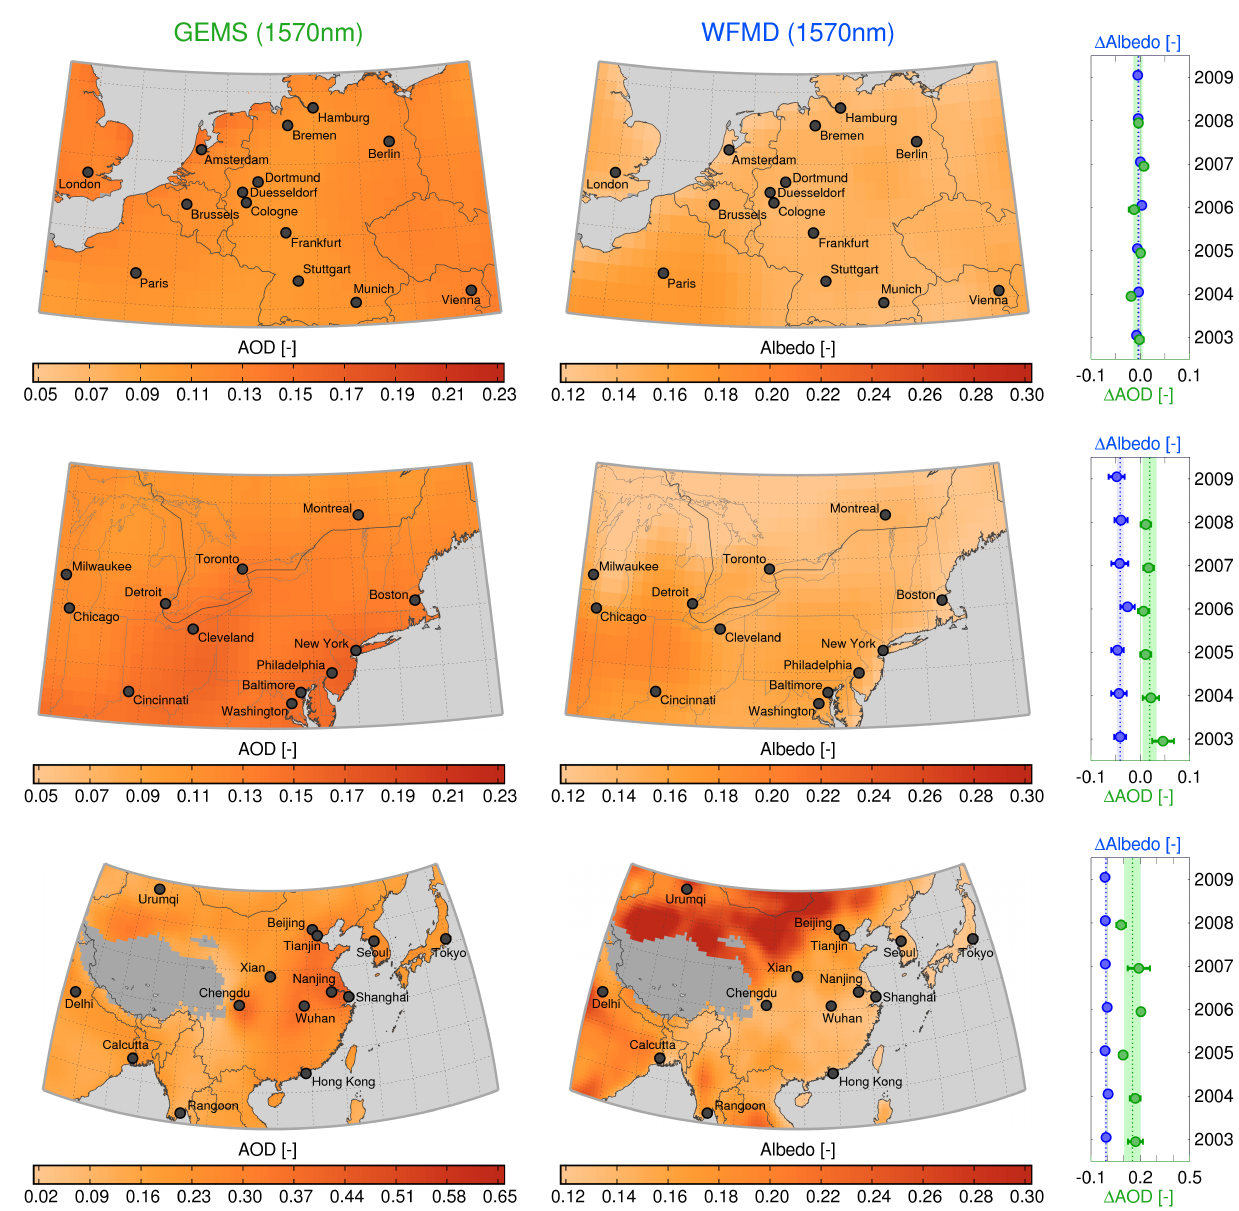
Fig. 4. As Fig. 3 but for